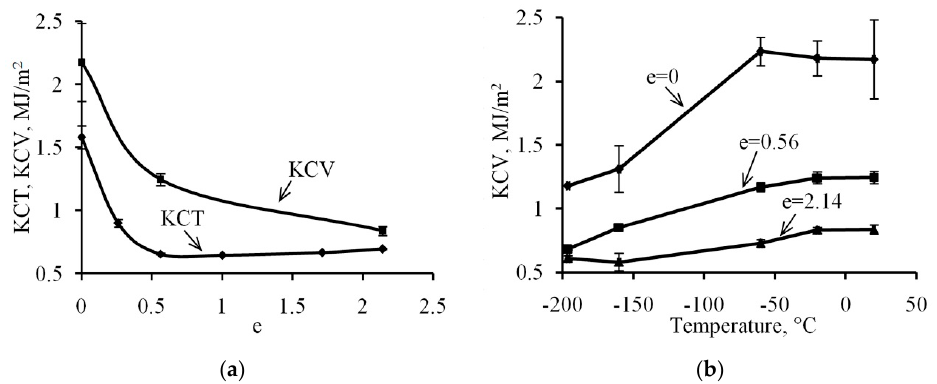
Figure 7. Results of impact strength testing of the 321 MASS after various degrees of deformation: ( a ) Relation of impact strength at room temperature to the true strain; ( b ) The temperature dependence of impact strength.